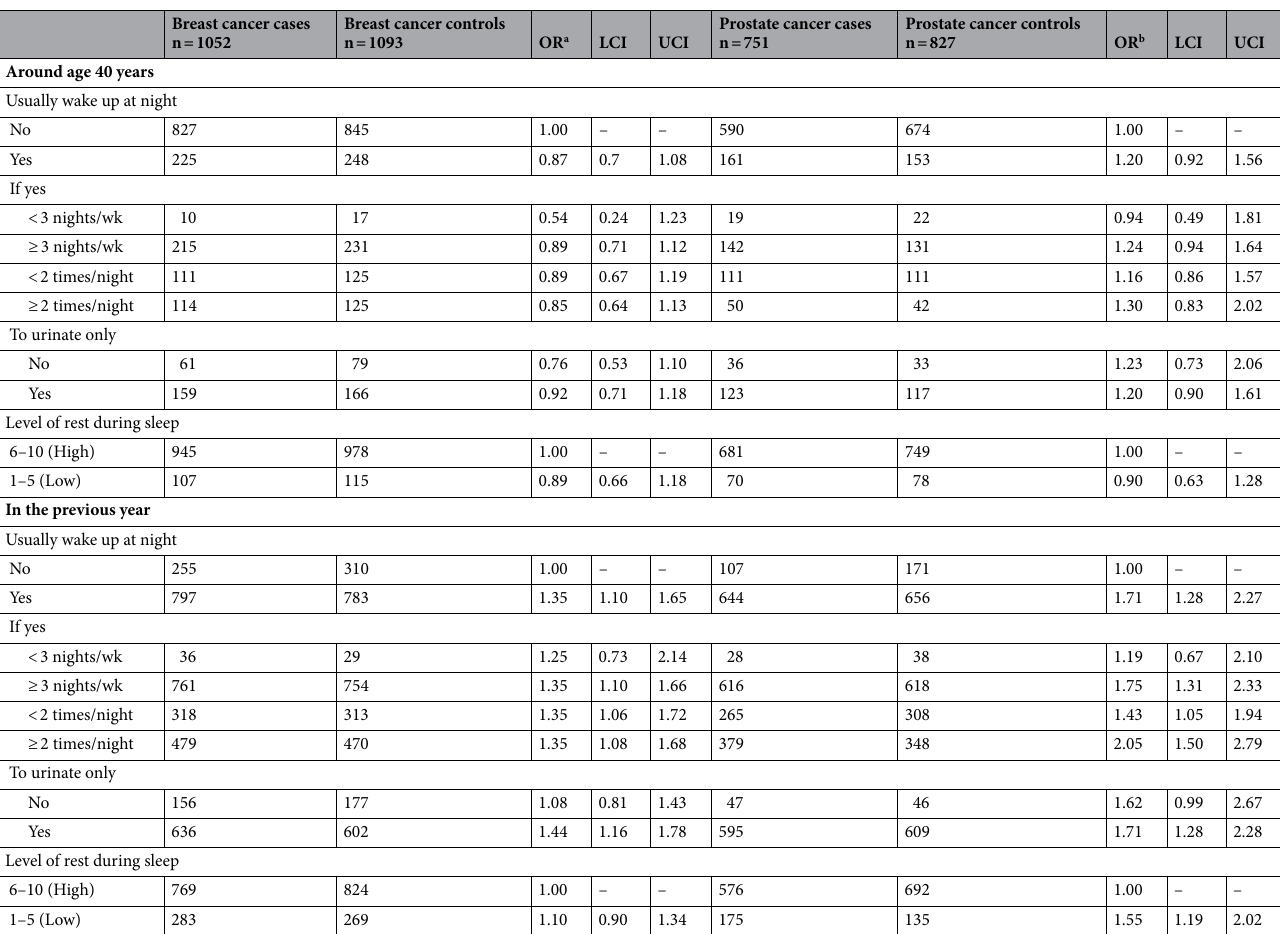
Table 5. Associations of sleep characteristics at either around age 40 years or in the previous year and breast and prostate cancer risk, supplemental questionnaire, MCC-Spain, 2008–2013. Note the sum does not equal the total due to missing data. a Models adjusted for age, centre, education, socioeconomic status, cigarette smoking status, family history of breast cancer in first degree relatives, BMI, physical activity, alcohol consumption, parity, age at first child, oral contraceptive, hormone replacement therapy, age at menarche, menopausal status. Categories for missing values were created for family history of breast cancer in first degree relatives, alcohol consumption, and hormone replacement therapy. b Models adjusted for age, centre,